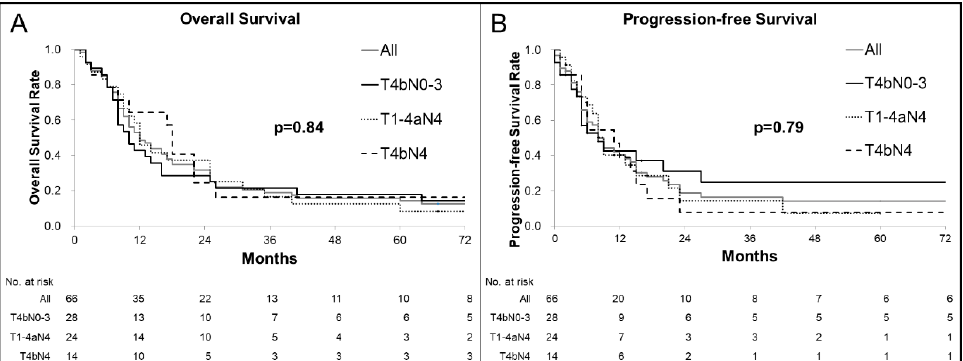
Figure 1. Kaplan–Meier curves for overall survival (OS) ( A ) and progression-free survival (PFS) ( B ): ( A ) Among all patients, the median OS was 13 months, with rates of 31.6% at 2 years and 14.2% at 5 years. There were no significant differences in OS between the patients with each T/N factor ( p = 0.84). ( B ) Among all patients, the median PFS was 8 months and the 2-year PFS rate was 18.7%. There were no significant differences in PFS between the patients with each T/N factor ( p = 0.79).